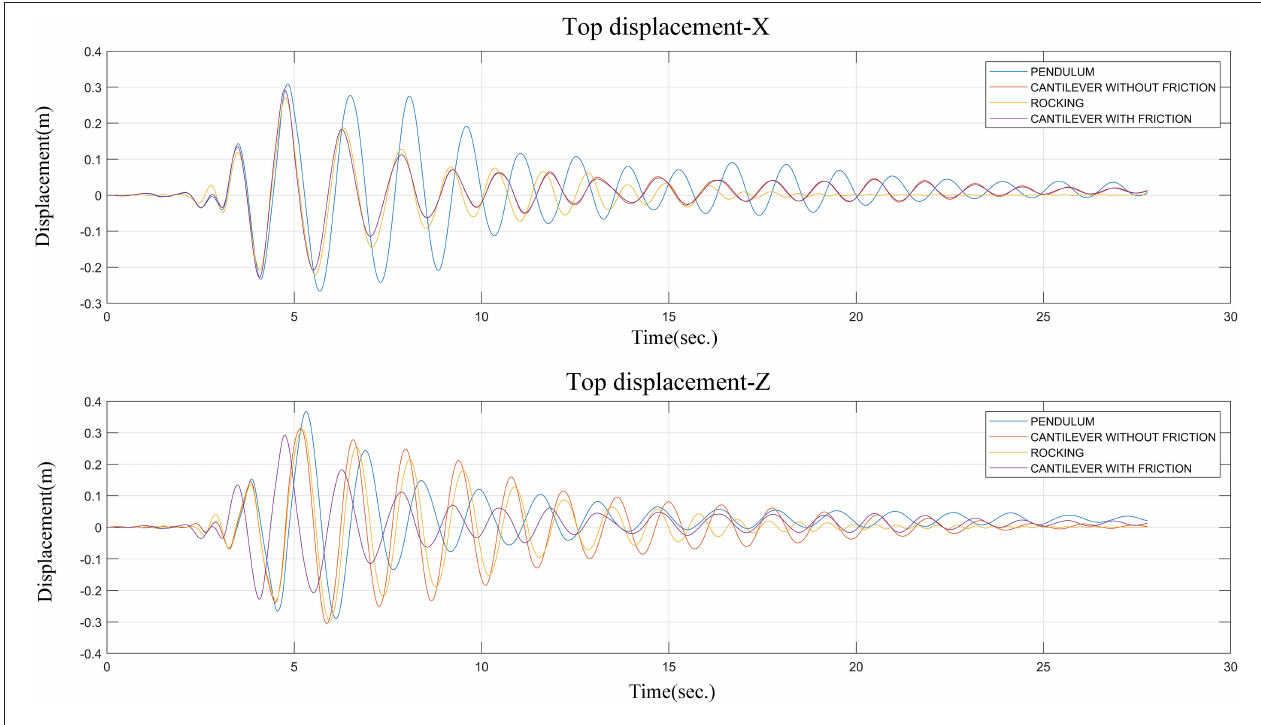
FIGURE 7 | Time-history response of the panel arrangements at the L’Aquila site.